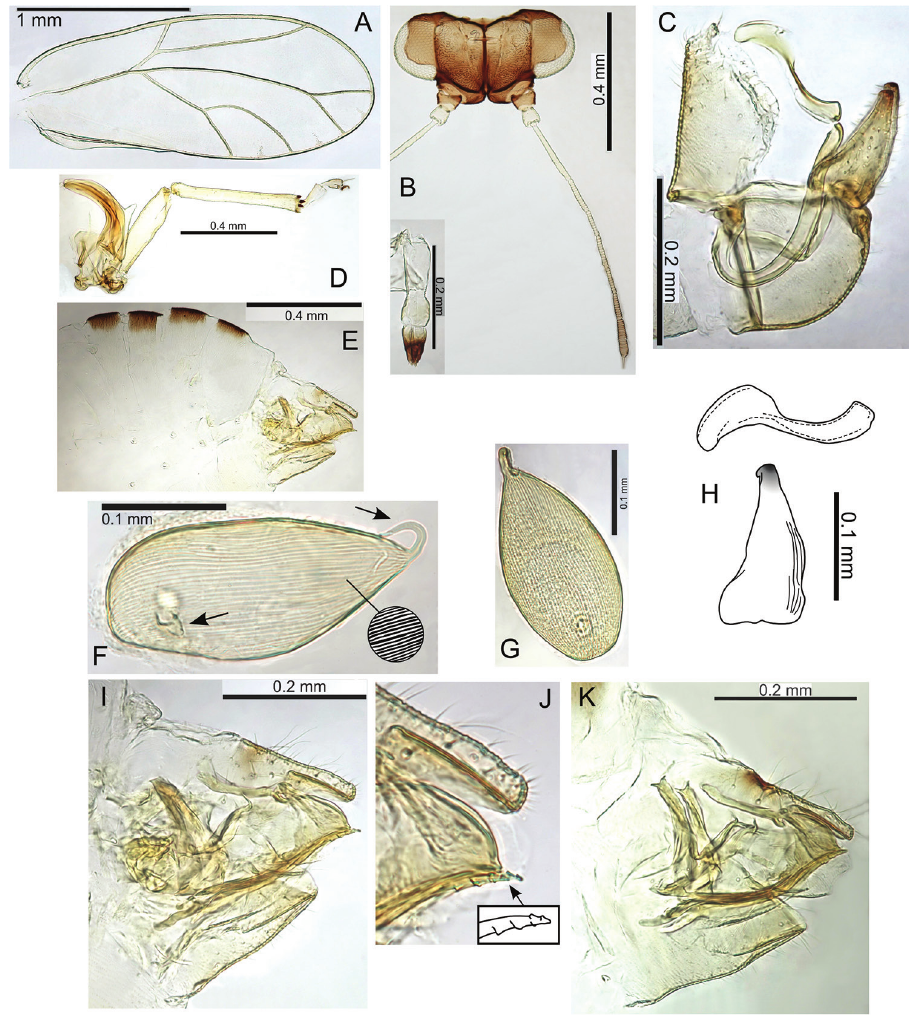
Figure 5. Pariaconus nigricapitus . A fore wing B head with antenna, and proboscis (inset) C male ter- minalia D hind leg E female abdomen and terminalia (holotype) F, G eggs (pedicel, tail, and striations indicated; holotype) H aedeagus and paramere I female terminalia (holotype) J ovipositor (serrations indicated) K female terminalia (Olaa,